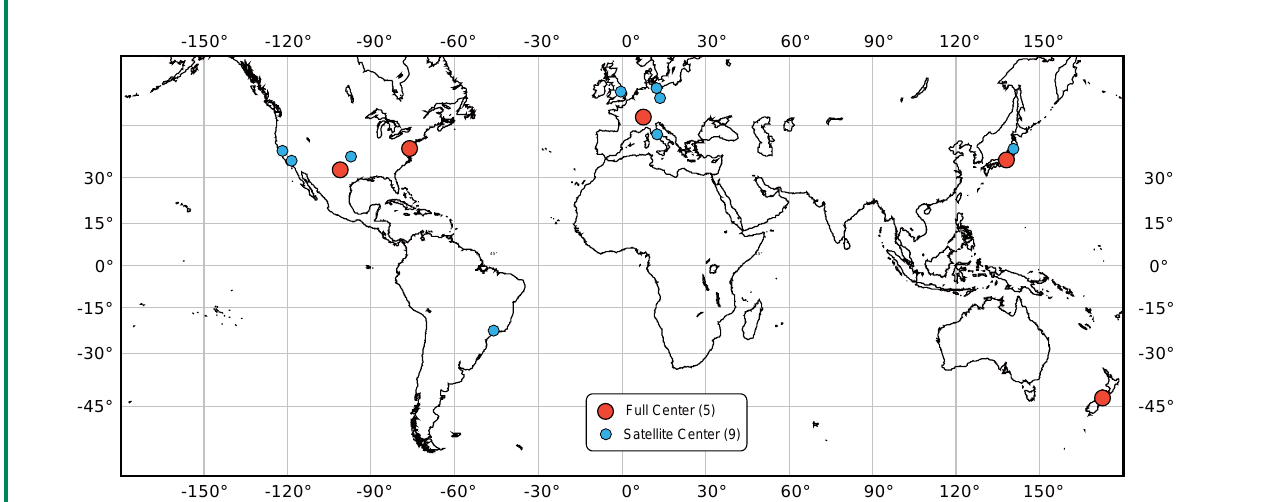
Figure 1. Locations of MRC collections. Full centers (red) hold slides for all four fossil groups. Satellite centers (blue) generally hold slides only for a single fossil